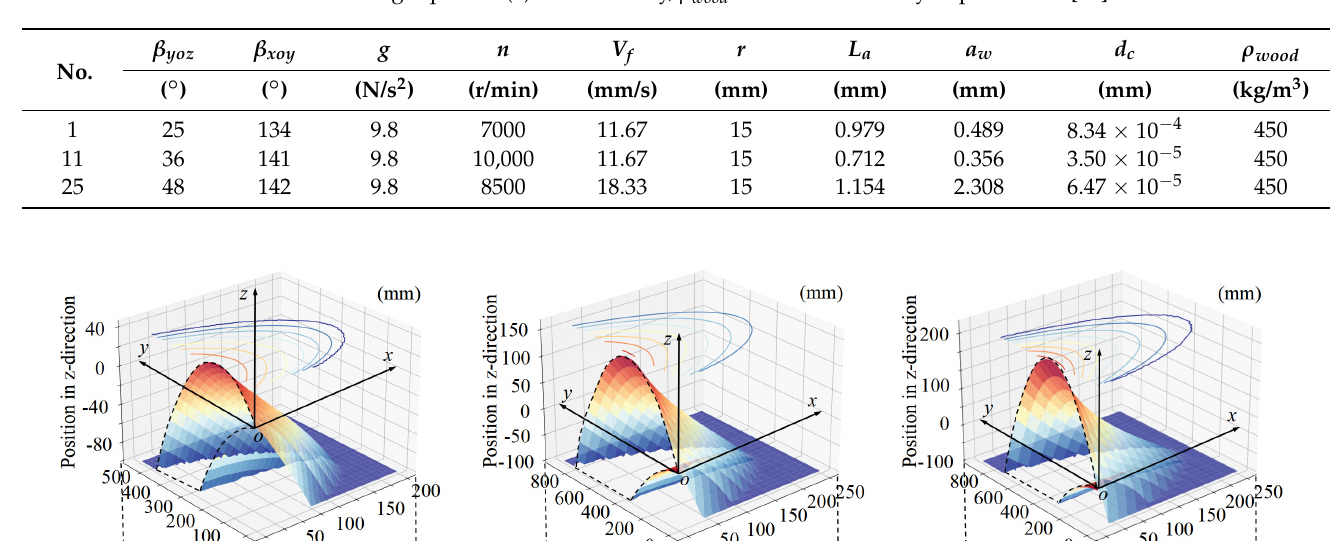
Table 7. Parameters necessary for solving the model are listed in the table below. Specifically, d c represents the chip thickness and is also equivalent to the single depth of cut a (cid:48) c , which is calculated using Equation (1). Additionally, ρ wood denotes the density of pine wood [24].